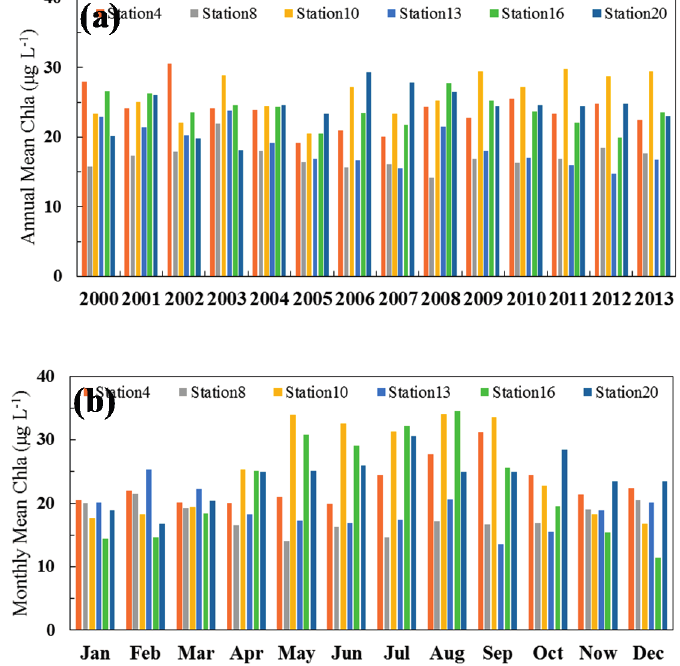
Figure 7. ( a ) Annual mean MODIS Chla and ( b ) Climatological monthly mean MODIS Chla for the six fixed sampling sites (Figure 1). Station 4 is in Meiliang Bay, Station 10 is in the NW Lake, and Station 8 is in the Central